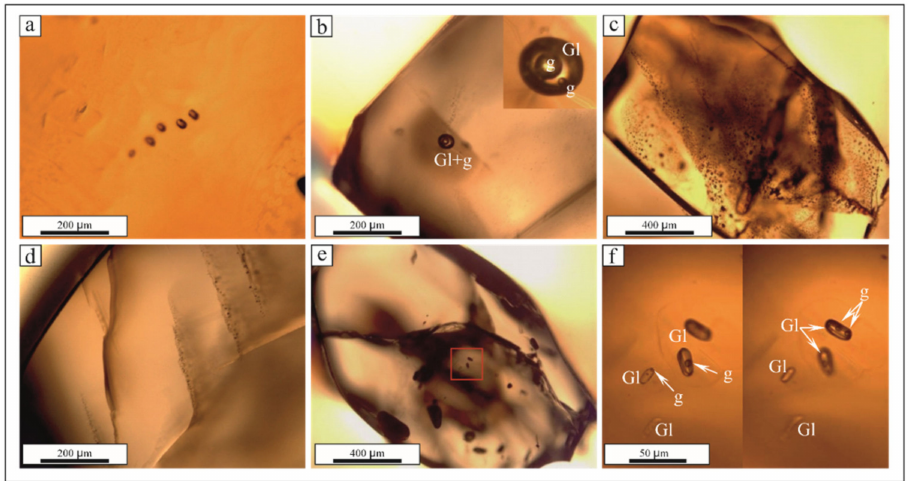
Figure 5. Groups and trails of silicate-melt and fluid inclusions in the zircons from Le Fosse di Novale transmitted light. ( a ) VR1-2; ( b ) VR1-4; ( c ) VR2-3; ( d ) VR3-6; ( e ) VR3-6; ( f ) VR3-5. Symbols: Gl—silicate glass, g—shrinkage gas bubble. Table 1. Chemical composition (EDS, wt %) of glasses from silicate-melt inclusions in the zircons from Le Fosse di Novale.